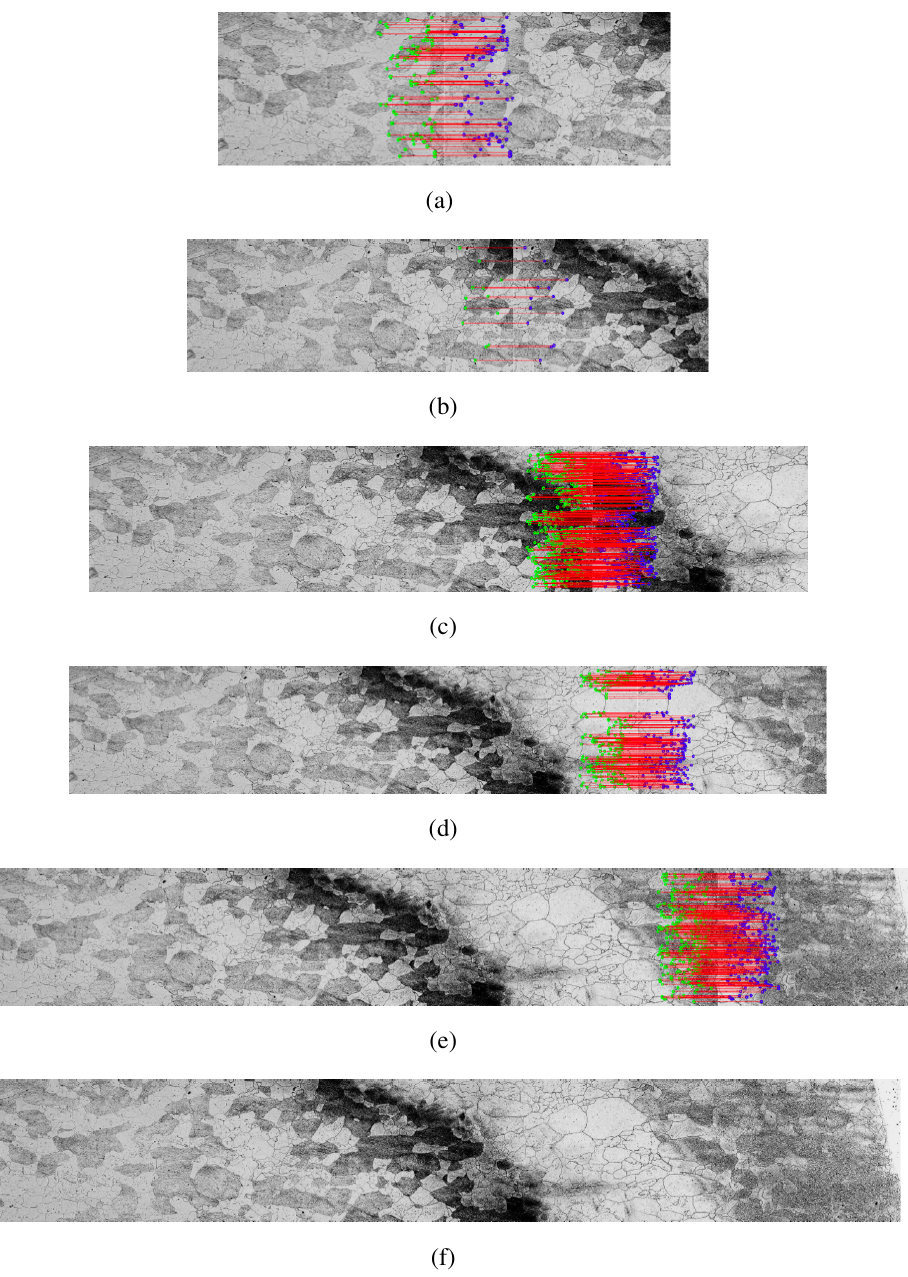
Figure 7. Mosaic construction example from the SURF method using LMED Homography method to find the matrix and the Linear Interpolation method for constructing mosaic images using the five images collected by the microscope—sample 9, ( a ) first step, mosaic of the two initial images; ( b )–( e ) mosaic previous result with an adjacent image; ( f ) final